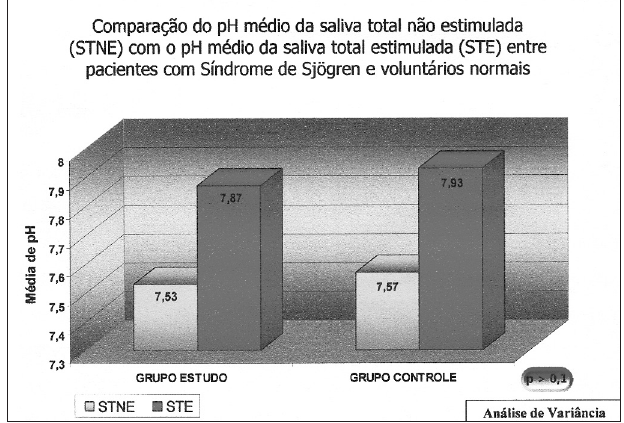
Figura 2. PH médio salivar em individuos com Sjögren (grupo estudo) e em indivíduos saudáveis. STNE- Saliva Total Não Estimulada. STE - Saliva Total